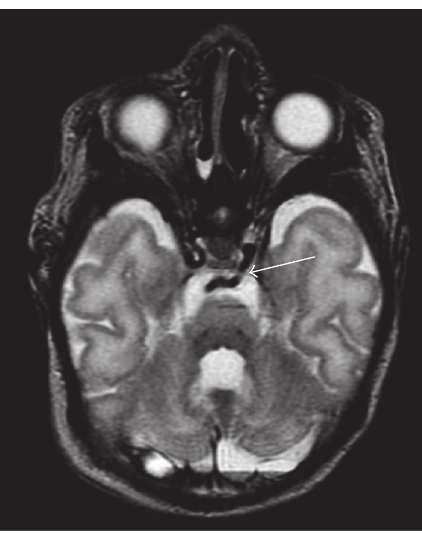
Figure 1: Axial T2-weighted MR image shows a persistent trigemi- nal artery (arrow) coursing from the cavernous left internal carotid artery posteriorly and medially to anastomose with the midbasilar artery.